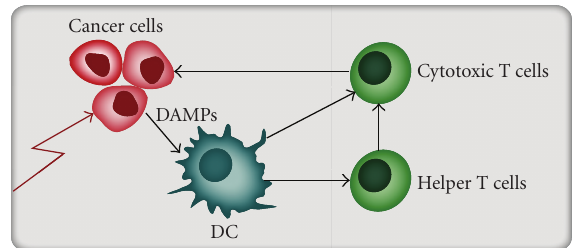
Figure 1: Induction of immunogenic apoptosis. Certain chemo- therapeutics agents (e.g., the anthracyclines) will induce immuno- genic apoptosis in cancer cell through induction of Danger- Associated Molecular Patterns (DAMPs). Examples of DAMPs are various Heat shock proteins and ecto-calreticulin exposure on the cancer cell surface. This pattern will induce dendritic cell (DC) maturation with development of specific T helper cell responses and enhancement of cancer-specific T cell